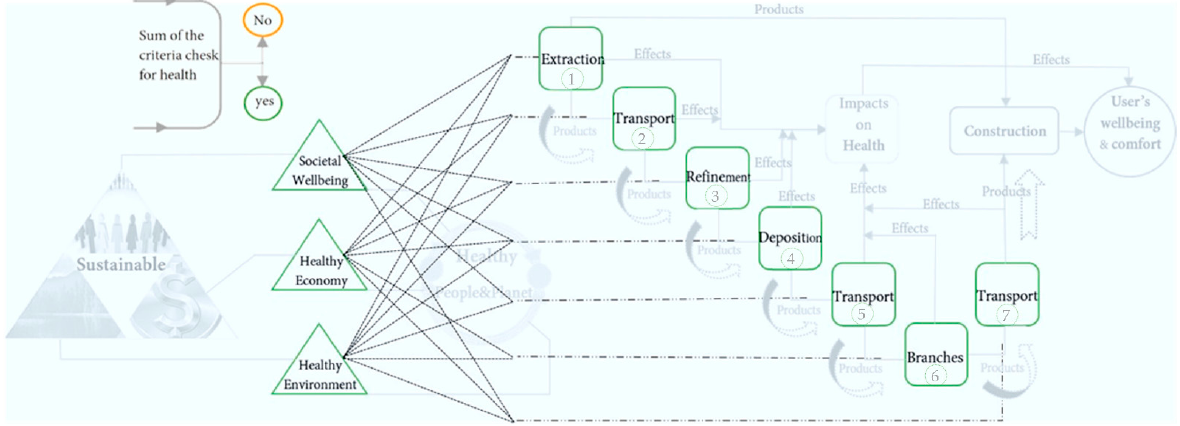
Figure 7. Example toolkit for materials selection to check health of each phase within processes of CMs with sustainability pillars.